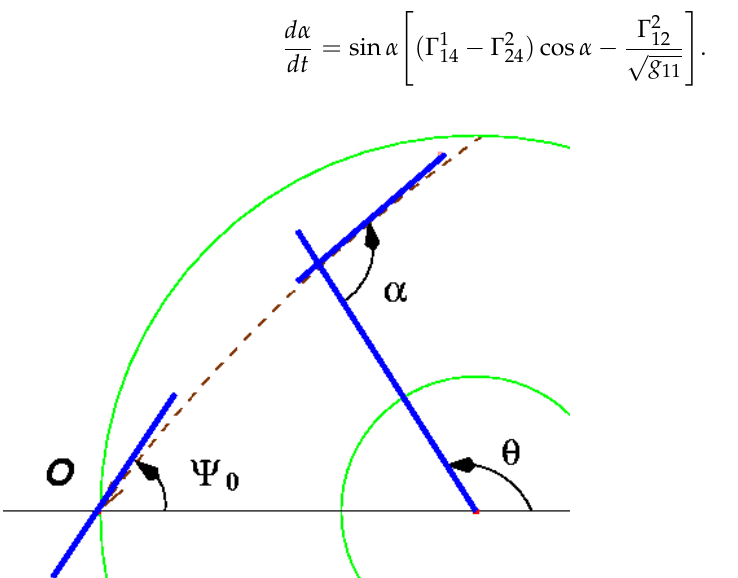
Figure 5. Plane of the LTB with t = constant and ϕ = 0. The angle α ( t ) and the observation direction Ψ 0 are